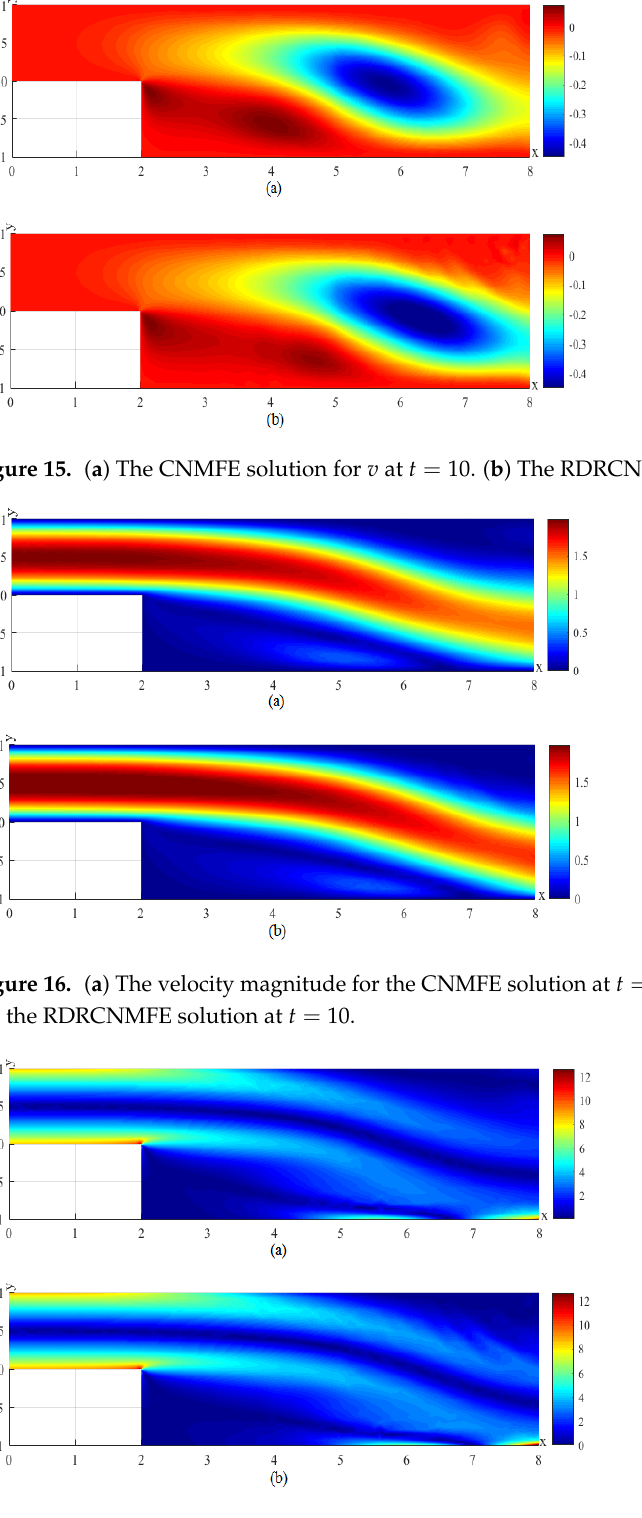
Figure 17. ( a ) The CNMFE solution for p at t = 10. ( b ) The RDRCNMFE solution for p at t =